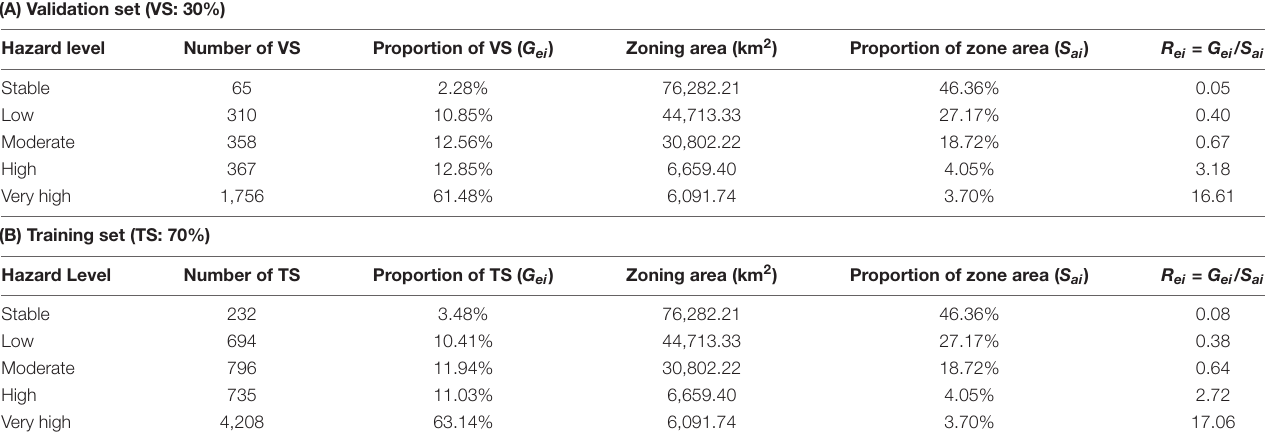
TABLE 7 | Distribution of the landslides in different hazard zones derived from Model 2 ( Table 5